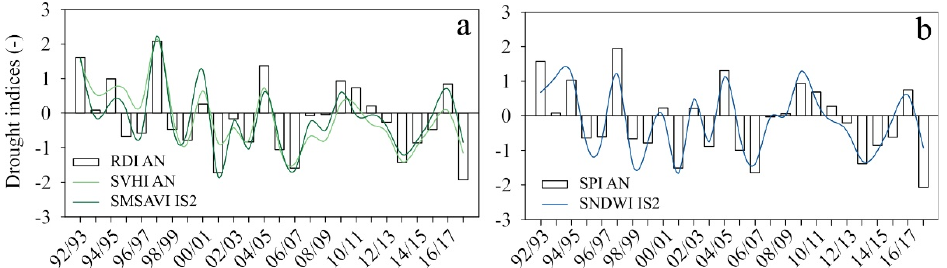
Figure 4. Meteorological drought and predicted surface reflectance–derived spectral drought indices in the Guadalupe Valley Basin, Baja California, Mexico, during 1992/93–2017/18 hydrological years. ( a ) Annual (AN) Reconnaissance Drought Index (RDI); standardized values (S) of Vegetation Health Index (VHI) and Modified Soil Adjusted Vegetation Index (MSAVI) during intervening season 2 (IS2). ( b ) Annual Standardized Precipitation Index (SPI) and standardized values of Normalized Difference Water Index (NDWI) during IS2.